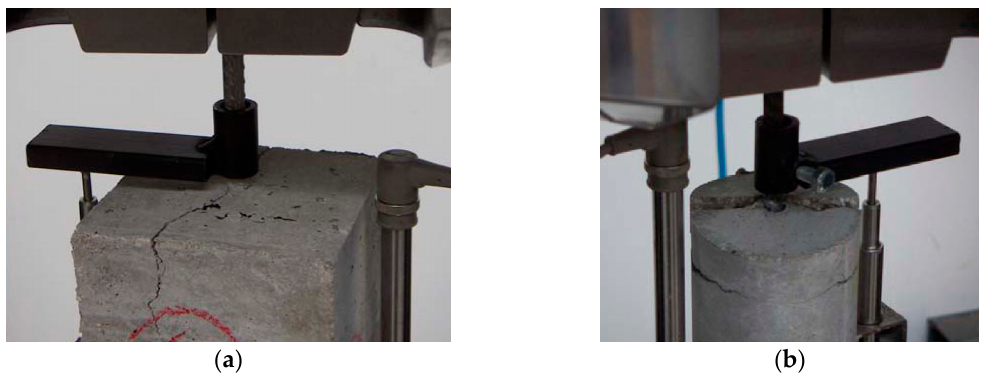
Figure 9. Specimens exhibiting pull-out failure accompanied by splitting failure: ( a ) specimen S7; ( b ) specimen S42.